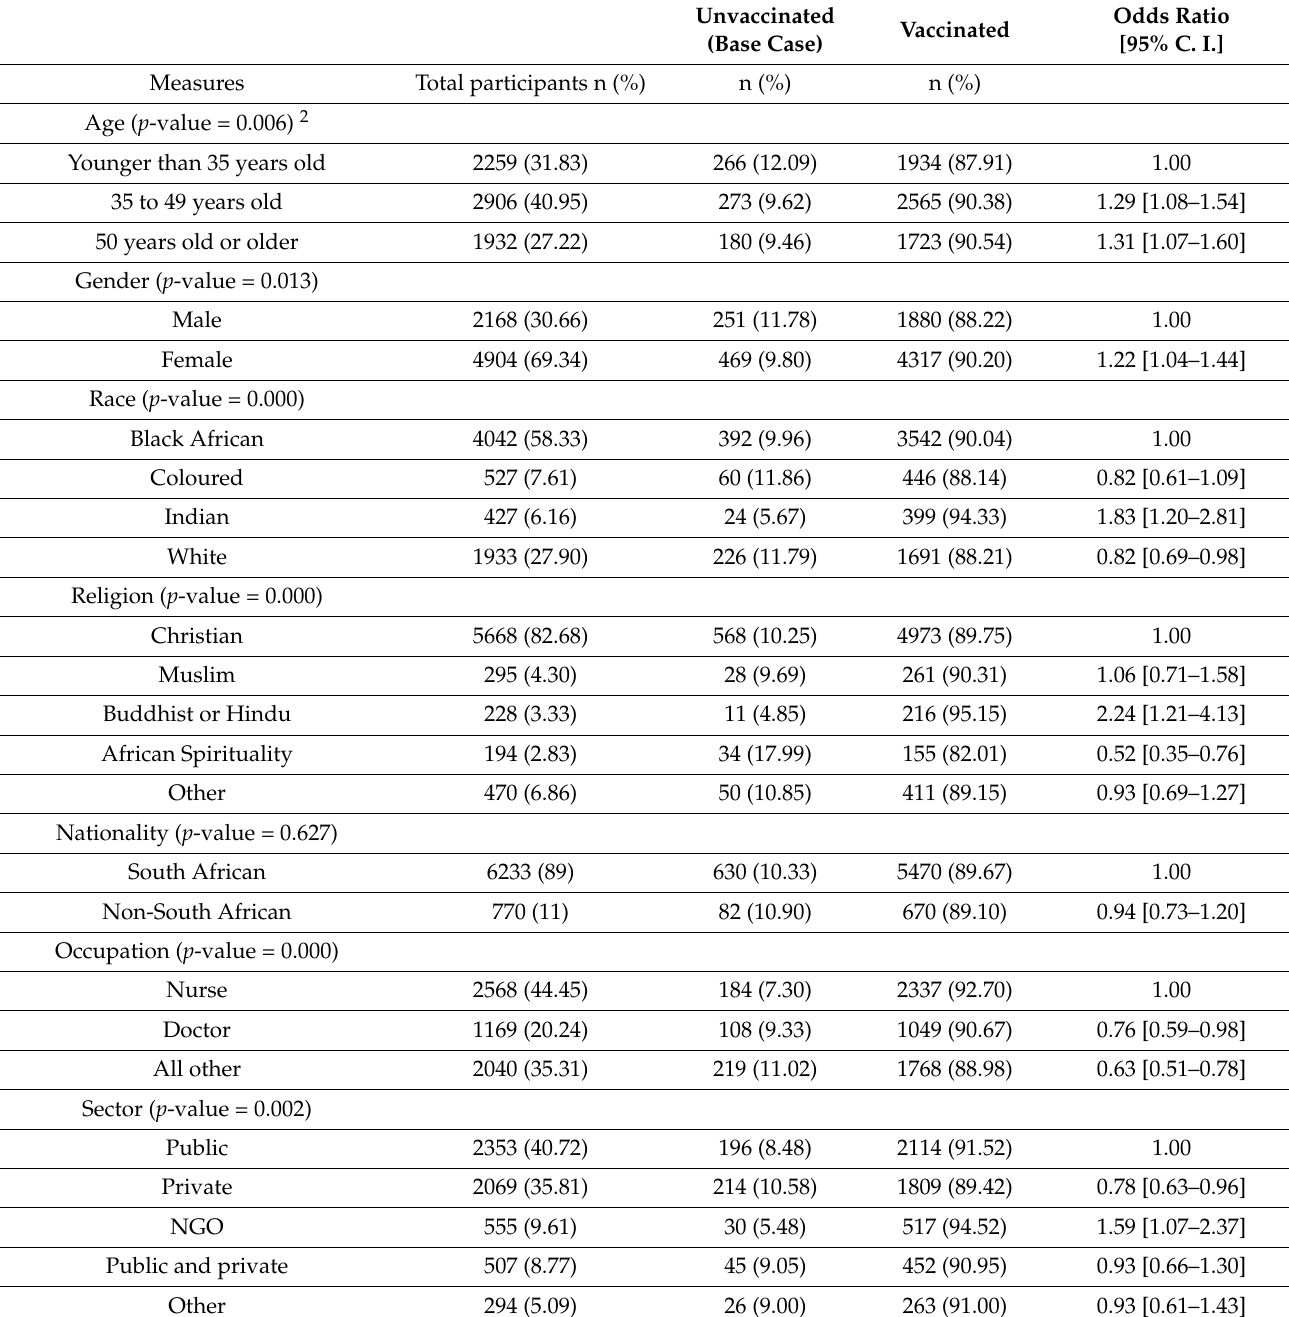
Table 1. Descriptive information and characteristics of healthcare workers according to vaccination status.